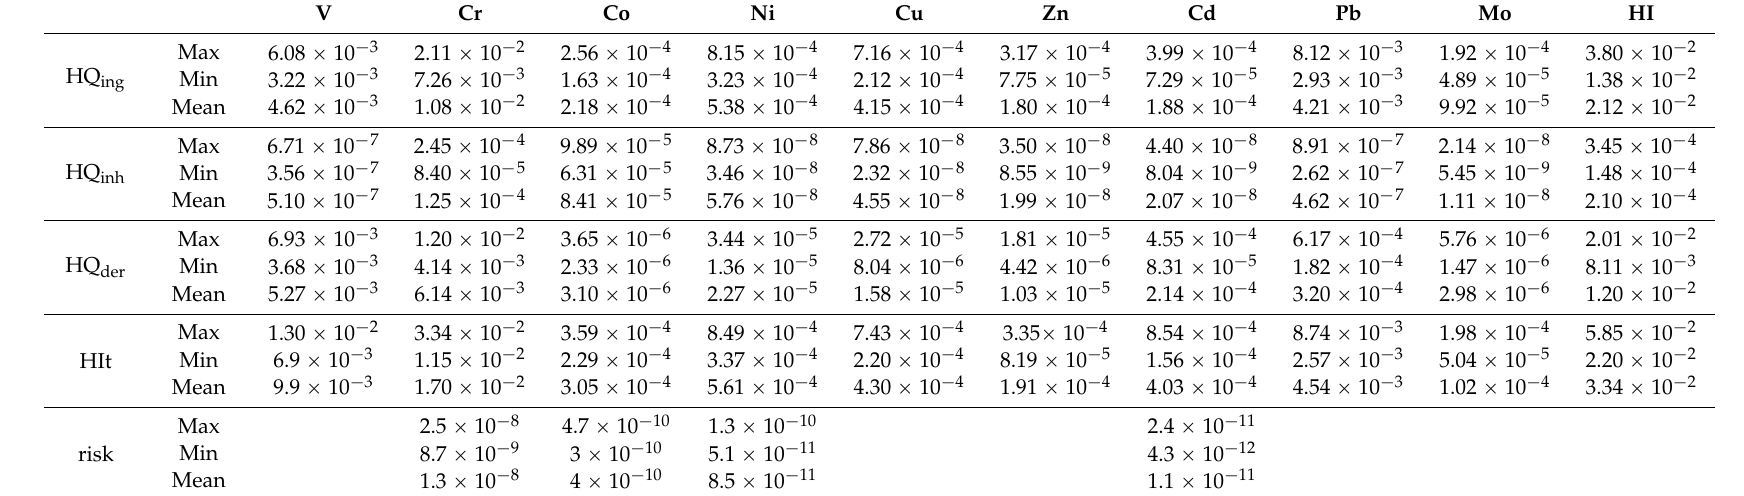
Table 7. Hazard quotient (HQ) and carcinogenic risk for each metal and pathway in the urban topsoil. V Cr